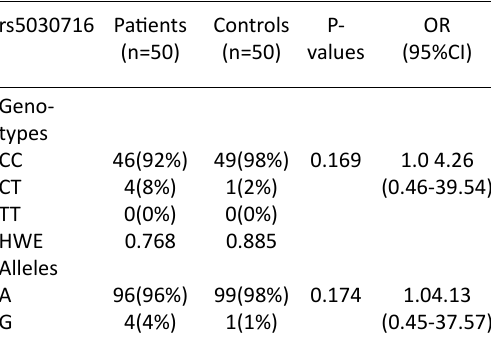
Table 5. Genotypes and alleles of TLR-4 rs3050716 in patients with seropositive IgM anti- toxoplasma Abs and controls rs5030716 Patients